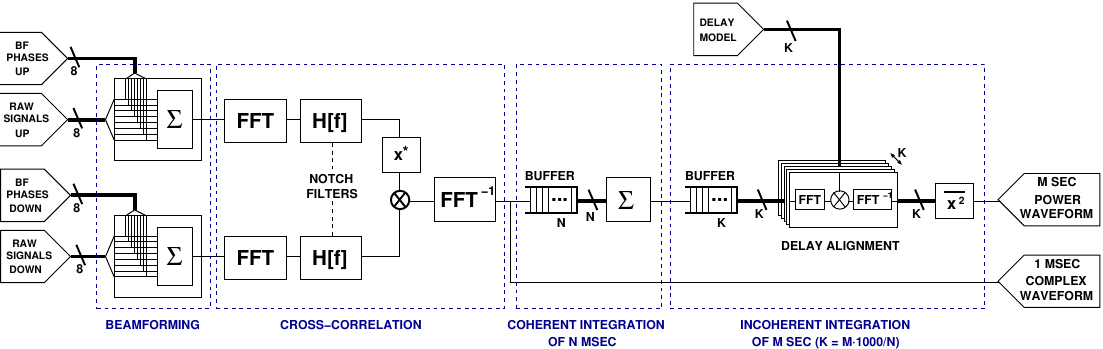
Figure 4. Schematic flow chart of the process followed to construct complex and power waveforms from raw